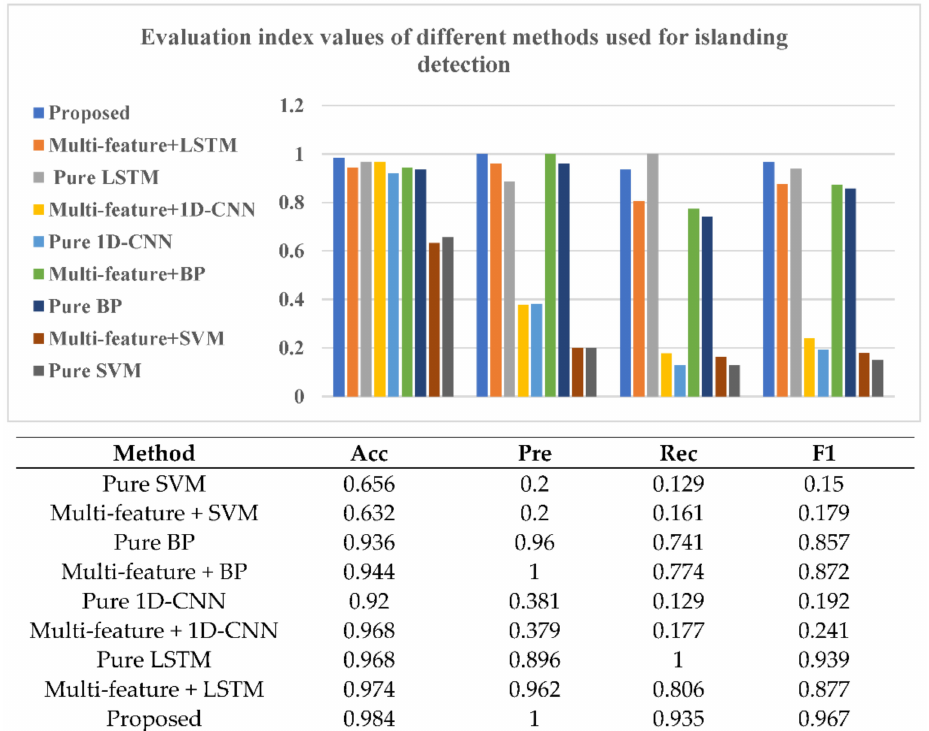
Figure 17. Contrasting experimental results of different